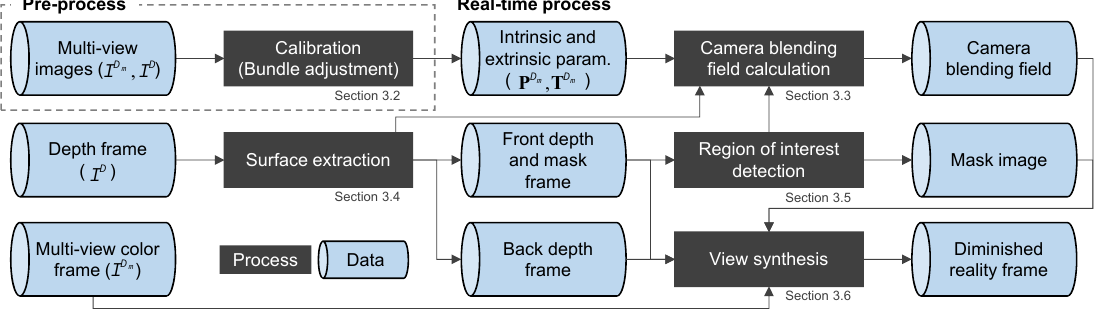
Figure 2. Overview of the proposed